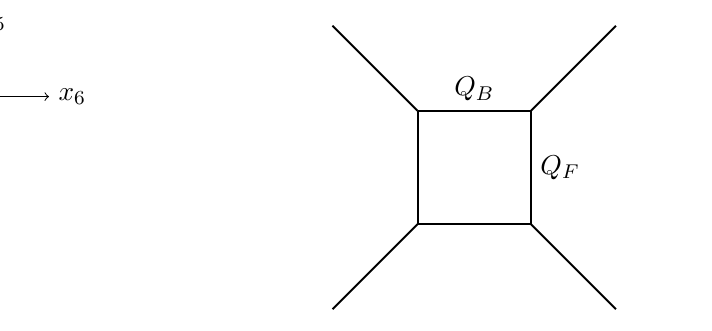
Figure 2 . ( p, q ) -brane web diagram in the x 5 , 6 directions for pure SU(2) gauge